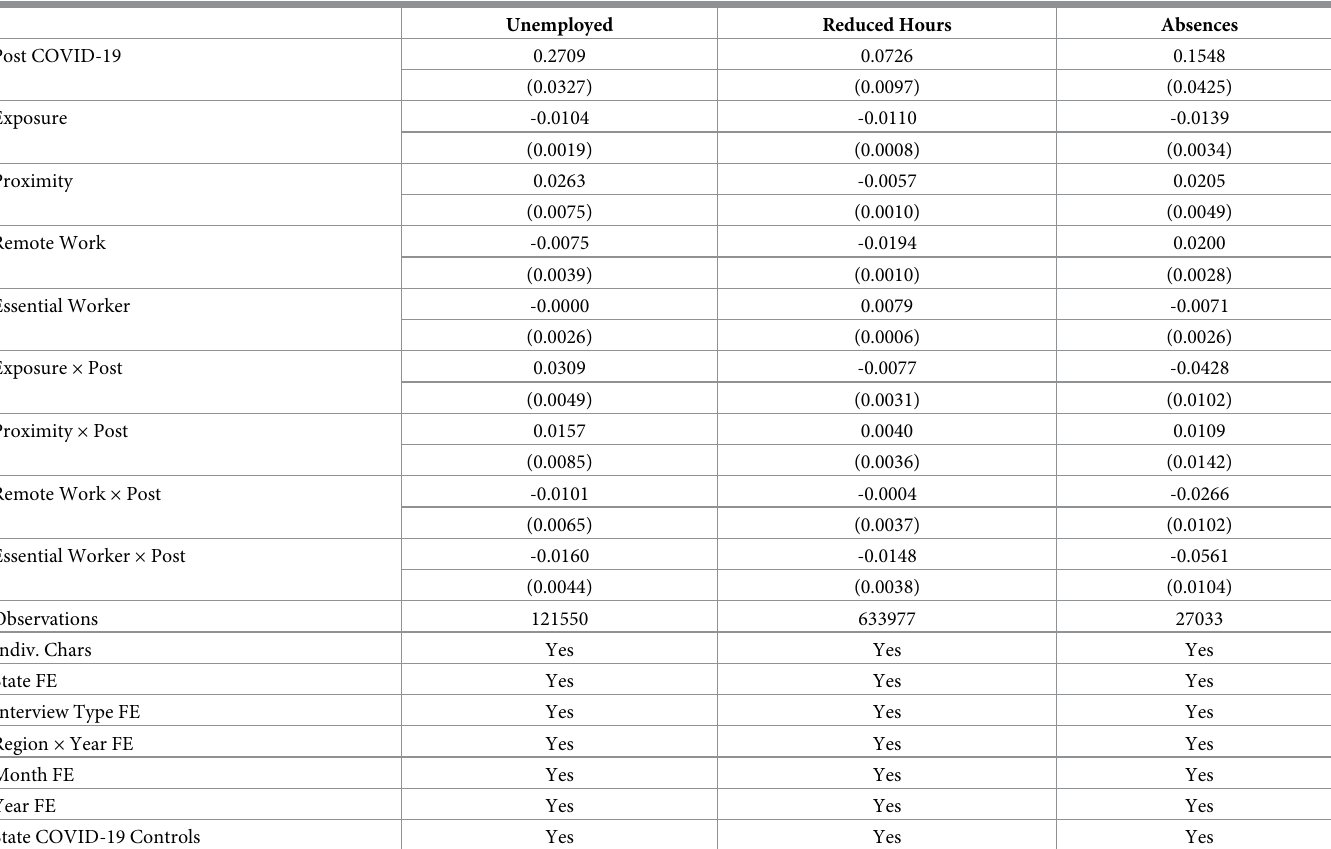
Table 10. COVID-19-related absences, layoffs and involuntary part-time: Exposure, proximity, remote and essential